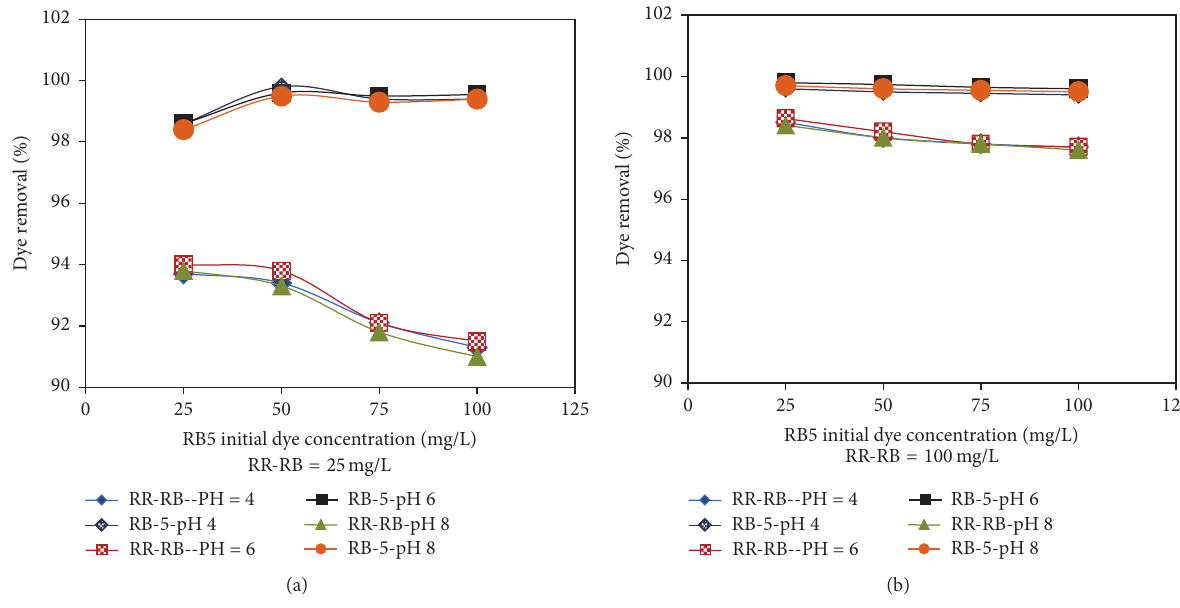
Figure 6: Effect of initial RB-5 dye concentrations on the removal percentages of RB-5 dye by QKCF at different pH in the presence of (a) 25 mg/L of RR-RB dye and (b) 100 mg/L of RR-RB dye (QKCF dosage = 0.1 g/100mL, agitation speed = 200 rpm, time = 4hr., and temp. = 25 ∘ C).